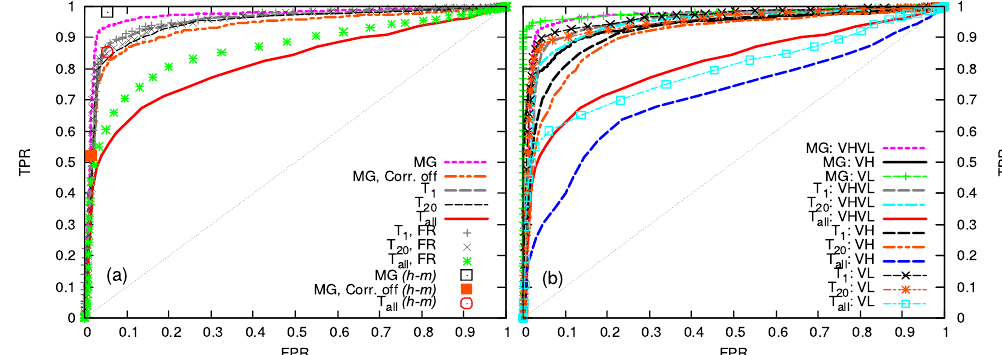
Figure 1. ROC curves for the different models. ROC curves obtained upon classification of the test human and murine databases, using the human learning database to learn the MG distribution, and to calculate the average distance for the “ T all ” and “ T n ” methods. Panel (a): ROC curves obtained using the full VHVL chain for classification, with or without CDR regions. Panel (b): ROC curves obtained using the VH or VL chain separately for classification. “Corr. off” indicates that correlations between residues have been removed in the MG model, “FR” refers to the curve obtained removing the CDRs and keeping just the framework regions, “h-m” indicates that classification is performed using both human and murine learning datasets as reference (see